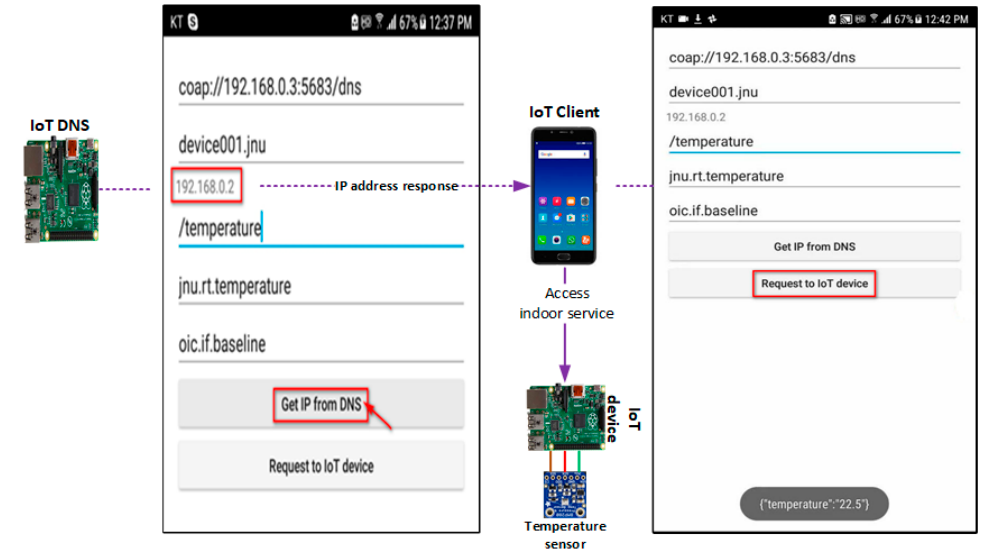
Figure 13 . Fragment of IoT resource discovery and accessing sensing data. Figure 13. Fragment of IoT resource discovery and accessing sensing data.